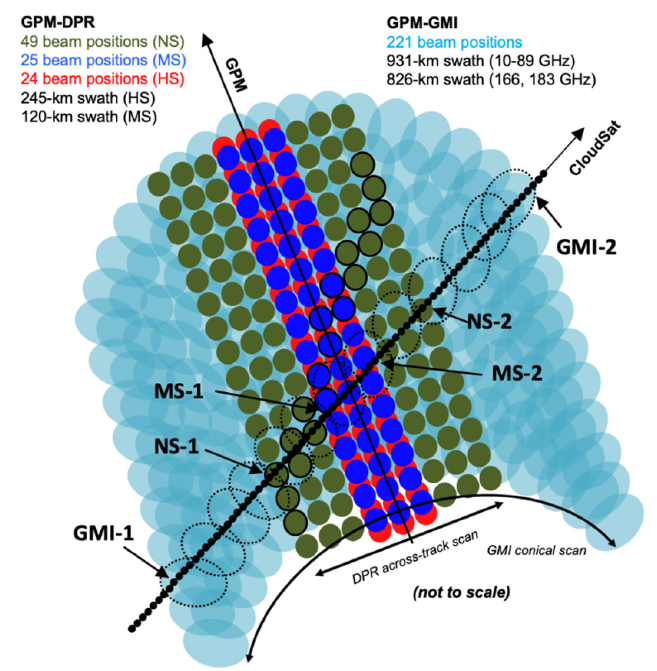
Figure 1. Illustration of a CloudSat-GPM coincidence segment. The location of each 1-km CPR beam position is denoted by the small black dots. The location of each DPR Ku-band swath (normal scan, NS) pixel is shown in green, the Ka-band (matched scan, MS) is in blue, and the Ka-band high-sensitivity (HS) scan is in red. The lower-resolution conically scanning GMI footprints spatially overlap across the swath, depending upon channel (light aqua). GMI-1, GMI-2 identify the GMI scan line numbers that cover the coincidence segment. Similarly, NS-1, NS-2 and MS-1, MS-2 represent the DPR scan line numbers for the DPR Ku- and Ka-band radar coverage, respectively. (Note: since 21 May 2018, the HS beam positions have been relocated to expand the Ka-band swath to cover the Ku-band